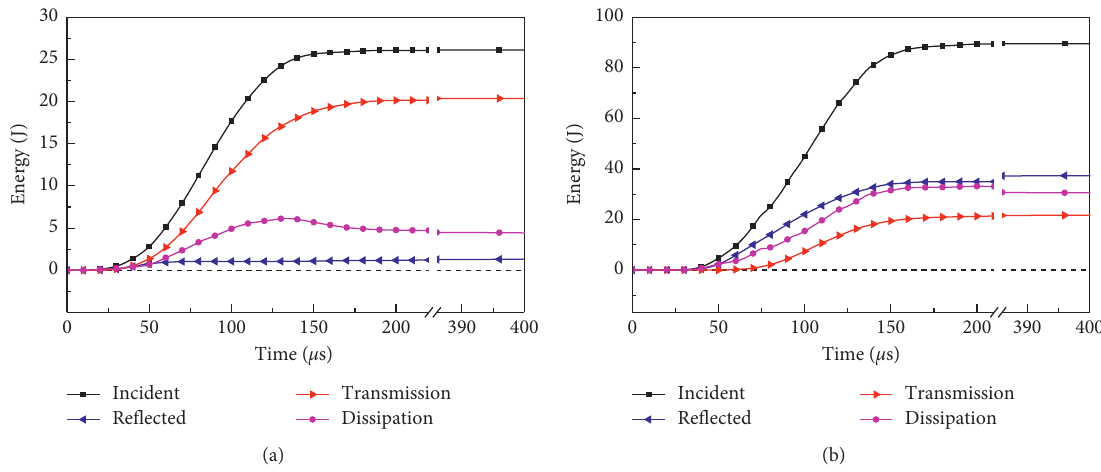
Figure 8: Time-history curve of energy change in SHPB compression test of limestone (a) T � 25 ° C, p � 0 . 4MPa. (b) T � 600 ° C, p � 0 . 9MPa.